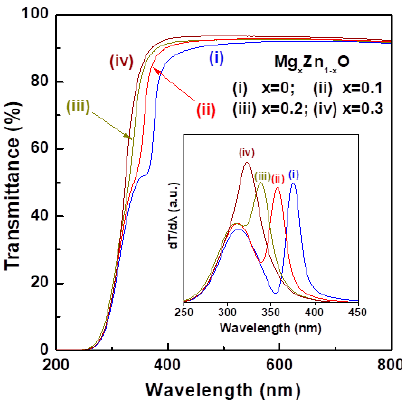
Figure 4. Optical transmission spectra of glass / Mg x Zn 1 − x O thin film samples. The inset shows the plots of d T / d λ versus wavelength of the corresponding thin film samples.